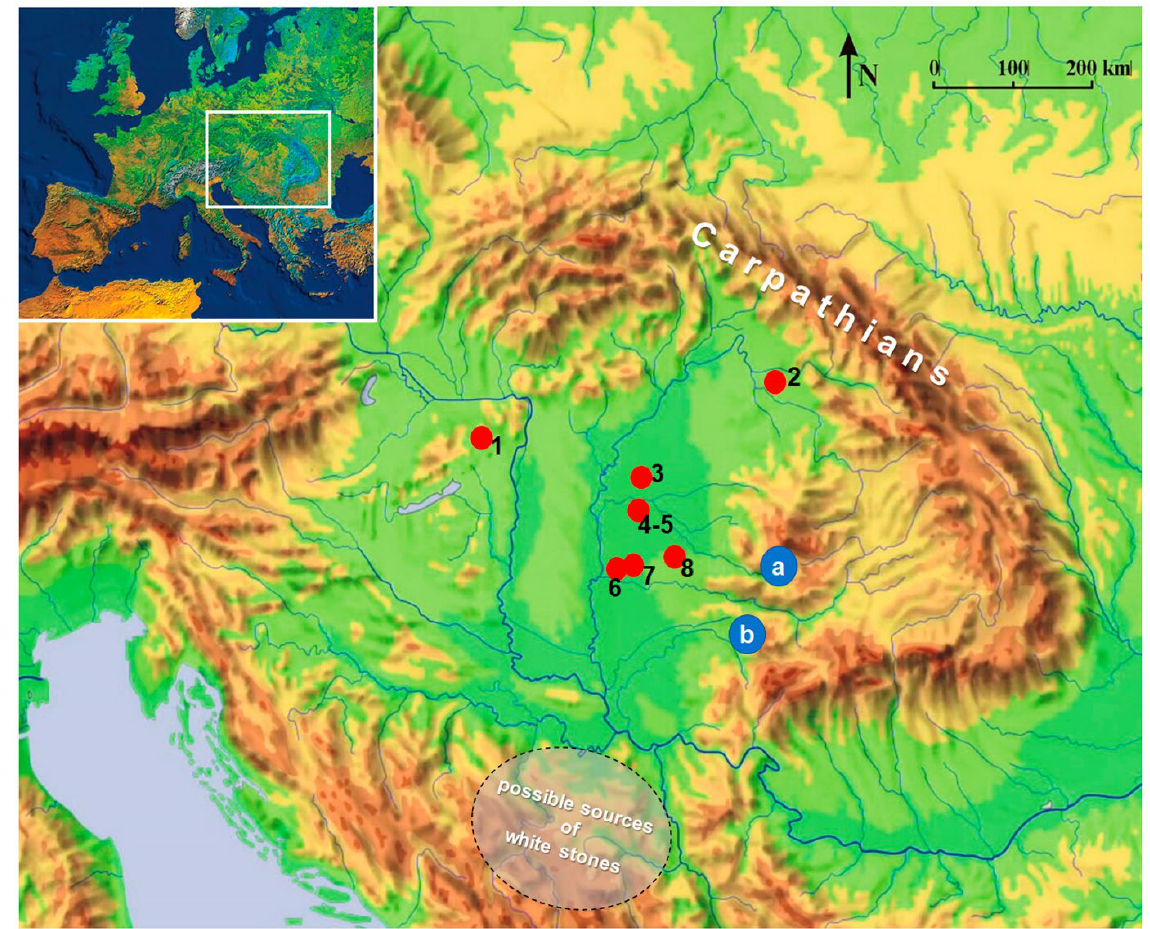
Figure 1. Map of the Carpathian Basin with the archaeological and geological localities mentioned in the text: 1: Bicske-Galagonyás; 2: Méhtelek-Nádas; 3: Ecsegfalva 23; 4- 5: Szarvas and Endrőd; 6: Tápé - Lebő; 7: Hódmezővásárhely -Gorzsa; 8: Pitvaros; a (Rusca Mts.) and b (S-Apuseni Mts.): identified sources of hornfels. The possible source area of the so called “white stones” (magnesite bearing siliceous rocks and others) is marked according to the map from Antonović (1997: